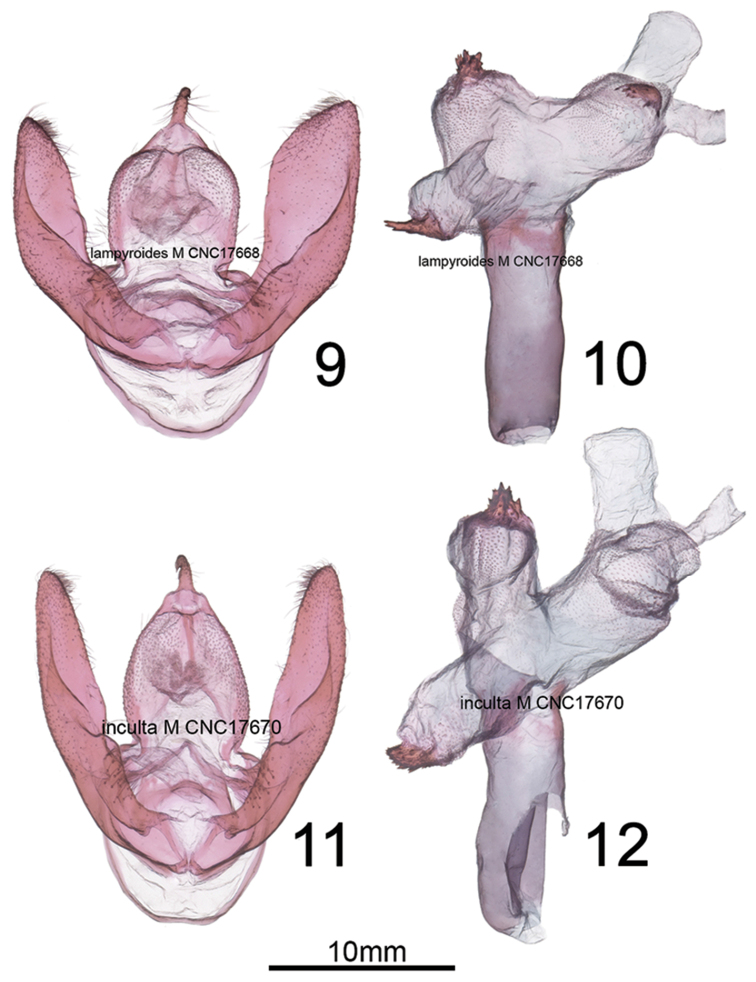
9–10 Male genitalia of Hypoprepialampyroides11–12 Male genitalia of Hypoprepiainculta.